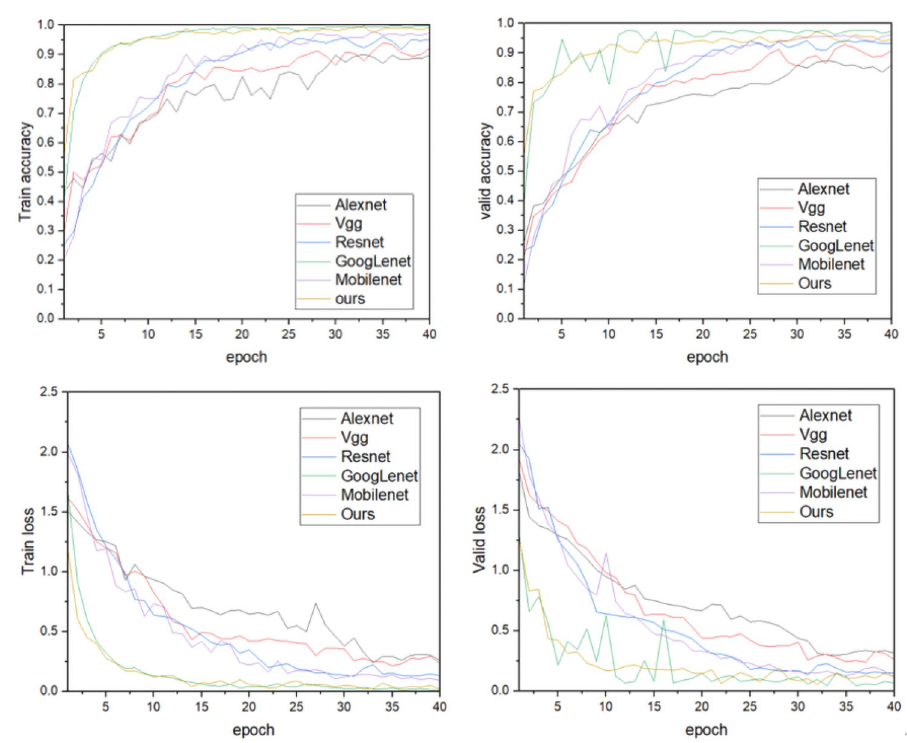
Fig 9. Comparison of the results of different network models.